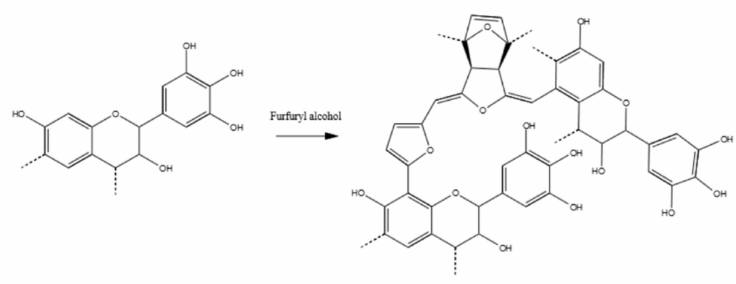
Figure 1. Possible reaction product of tannin–furfuryl alcohol polymers